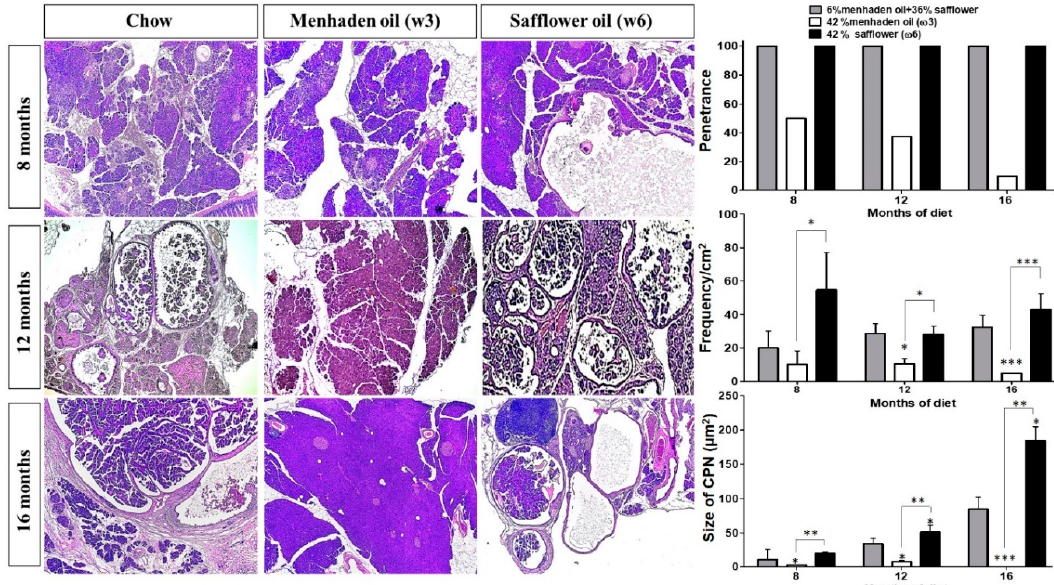
Figure 1. ω 3-enriched diets protect against, whereas ω 6-enriched diets accelerate pancreatic tumorigenesis in vivo. EL-Kras (KRAS) mice with mutant KRAS expression restricted to the pancreas acinar compartment via a rat elastase promoter were employed as a model of early pancreatic tumorigenesis. Mice were then administered either a control diet, or a diet enriched in ω 3 or ω 6 fatty acids, respectively, for 7, 11, or 15 months. Mice were sacrificed, tissues were sectioned and stained with H&E, and lesion frequency/penetrance and cystic papillary neoplasm (CPN) size were quantified by two blinded investigators (C.T. and G. M). * p -value < 0.05: ** p -value < 0.01; *** p -value < 0.001. The asterisks above each column represent the significance compared to the control diet. The significance between both diet is indicated by connecting lines.